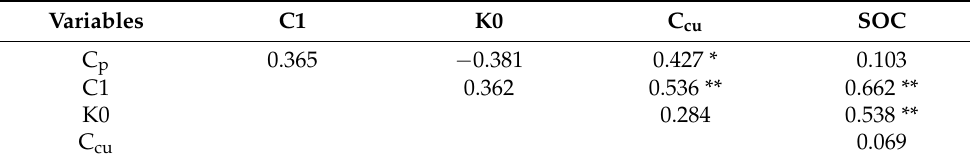
Table 8. Relationship between SOC, C 1 , C cu , C p and